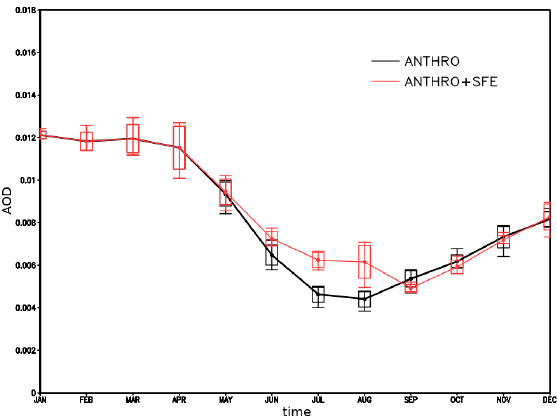
Figure 11. Annual variation of the optical thickness of 550 nm for BC in the Arctic atmosphere. Black curves—anthropogenic emissions, red curves—anthropogenic and fire components.